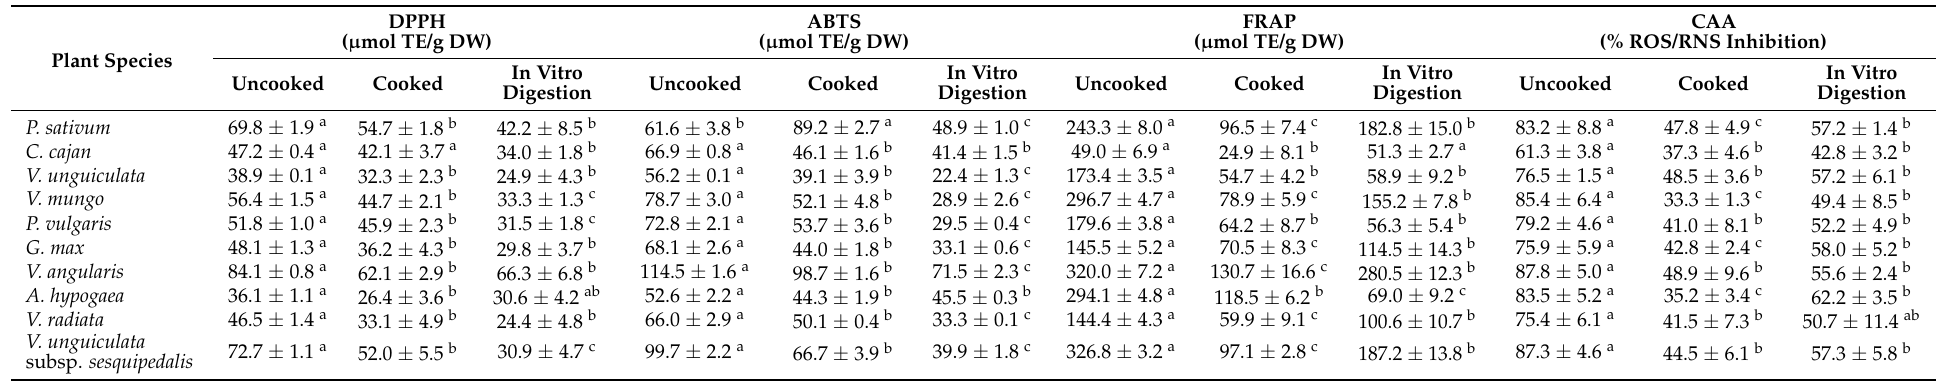
subsp. sesquipedalis Different superscript letters indicate significant differences at p <